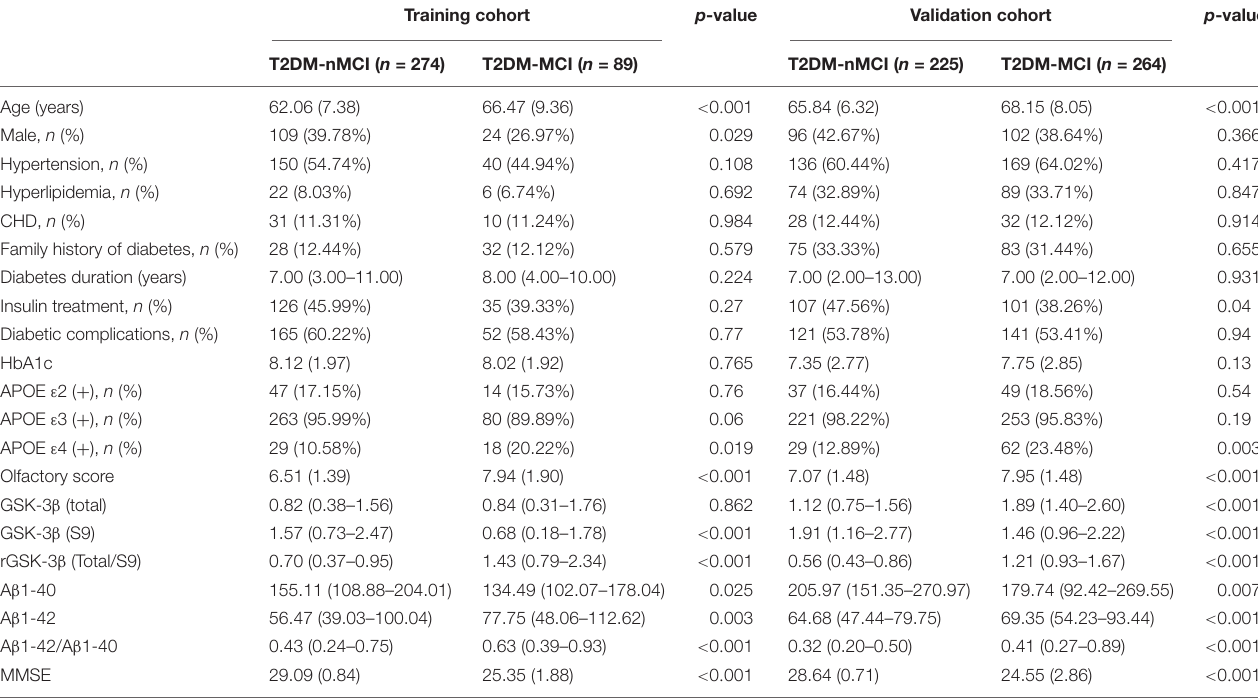
TABLE 1 | Baseline characteristics and potential biomarkers of T2DM patients in the training cohort and the validation cohort. Training